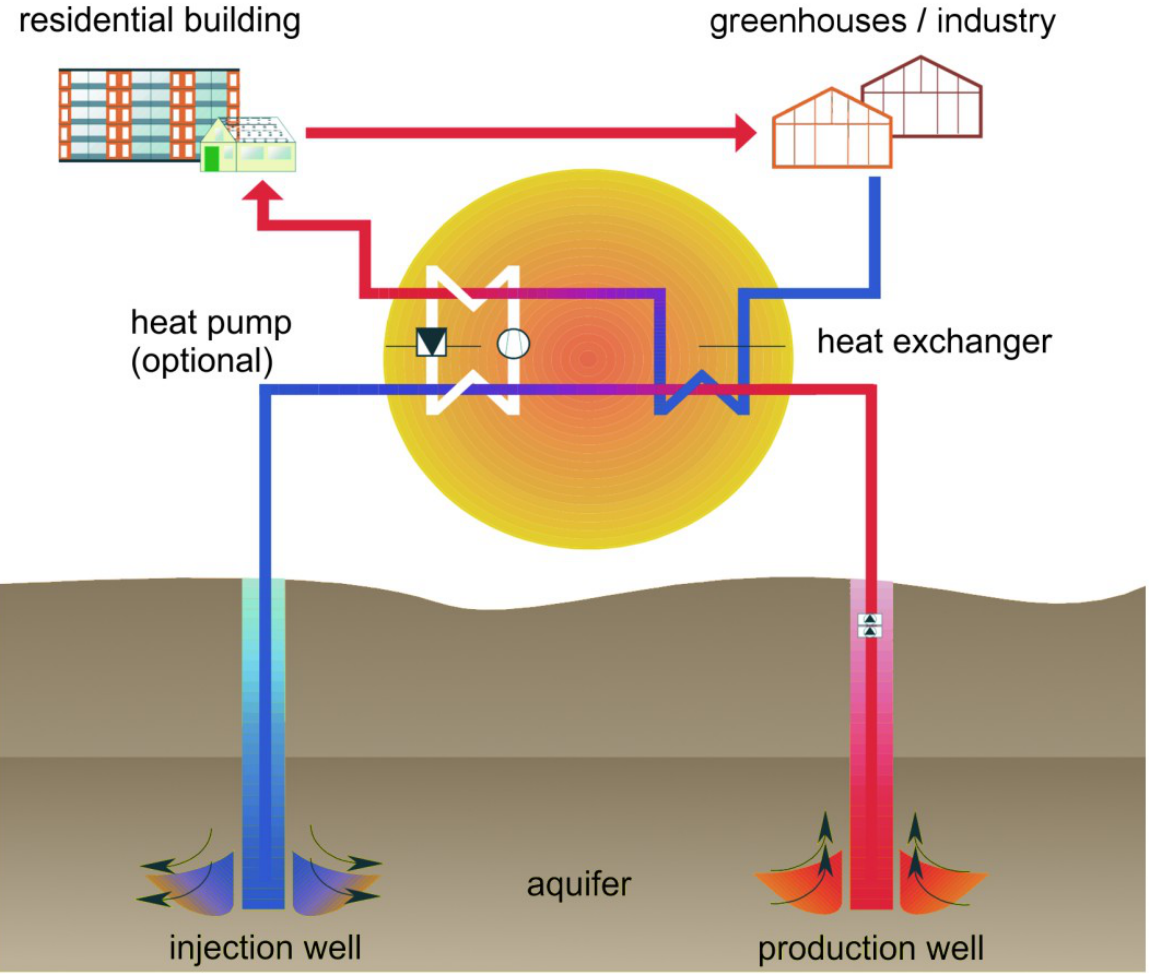
Figure 1. Diagram of a doublet for hydrothermal